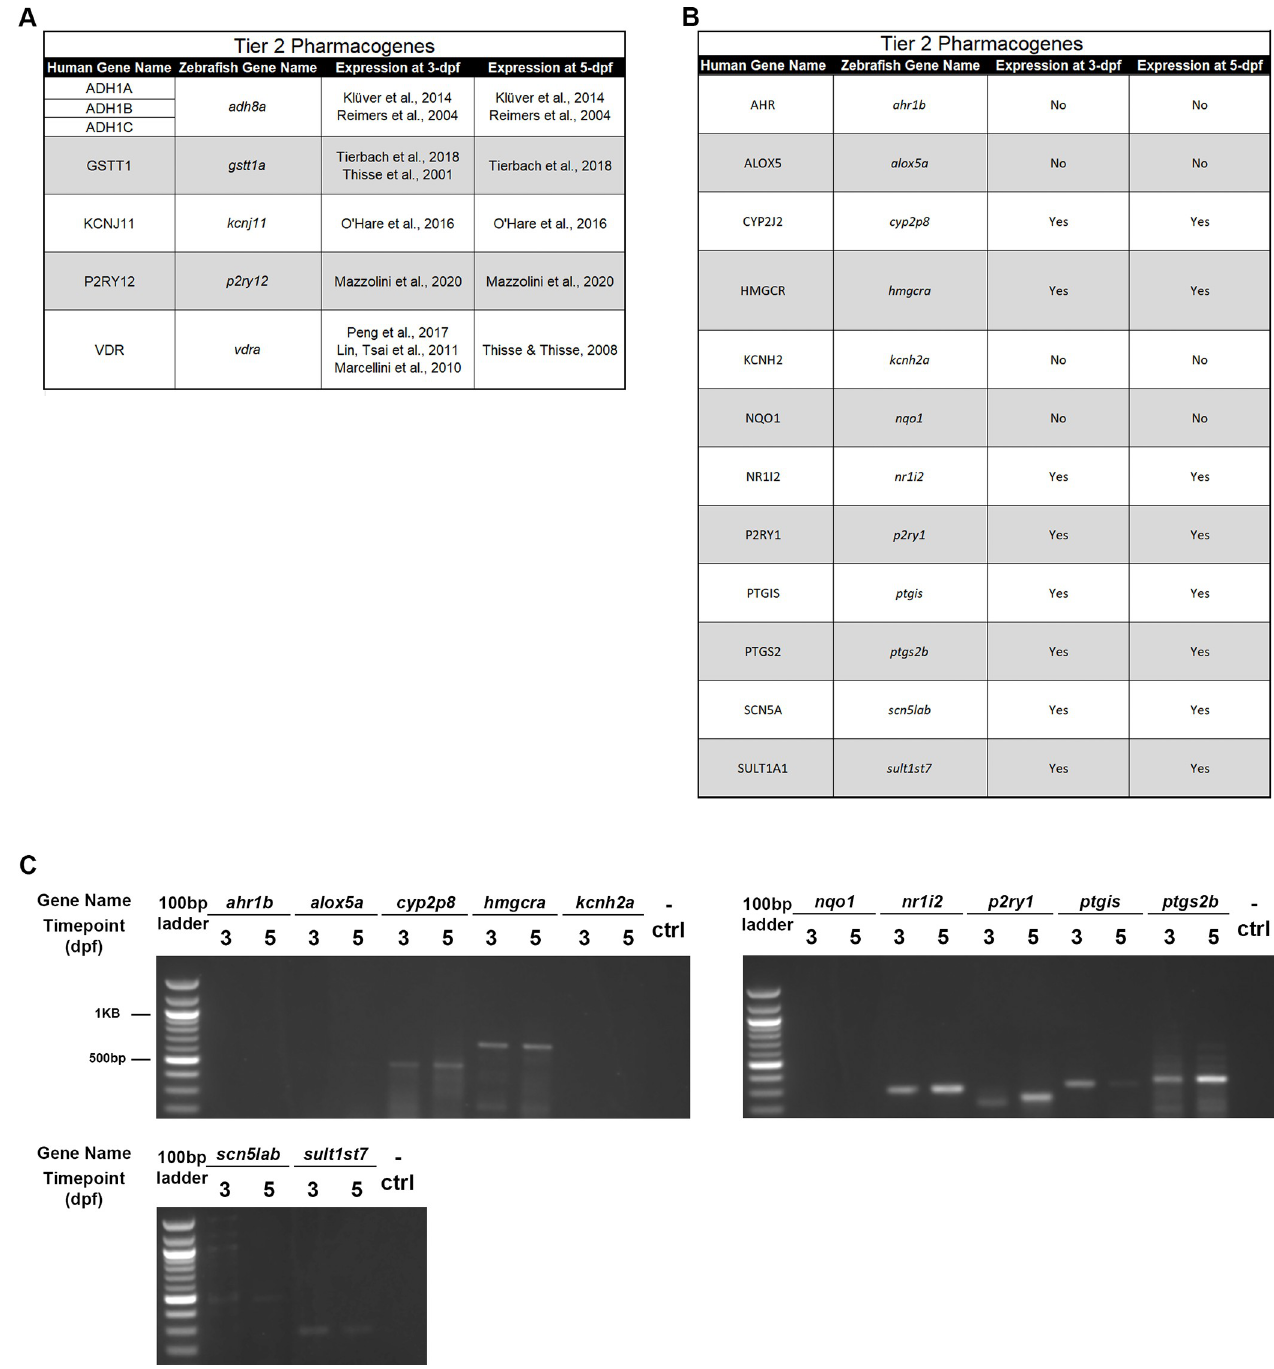
Fig 4. Zebrafish expression of Tier 2 pharmacogenes. A. Previously published literature housing information on expression of Tier 2 pharmacogenes in zebrafish. B. Tier 2 pharmacogene expression in zebrafish: “Yes” indicates expression was noted, “No” indicates no expression found. C. RT-PCR gel results for each Tier 2 zebrafish ortholog not previously identified in the literature. Gene name is listed at the top with the 3-days post fertilization (dpf) and 5-dpf included under the respective gene in alphabetical order. Each gel had a 100-base pair (bp) ladder (left) and a negative control (- ctrl, left).